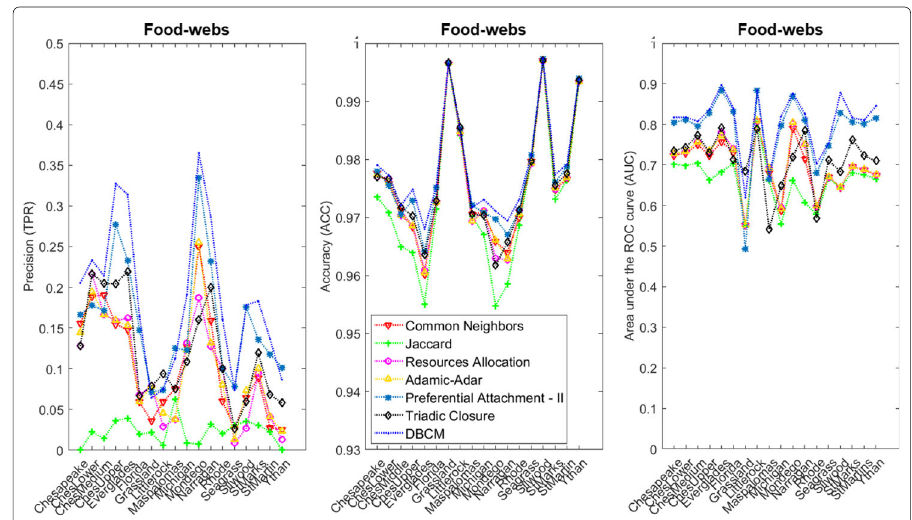
Fig. 3 Comparison of link-prediction algorithms when applied to the (directed version) of the food-webs. Our entropy-based approach to link-prediction performs better than the other algorithms. Here, we have retained only the recipe s PA (cid:10)(cid:10) ij ∝ k out i · k in